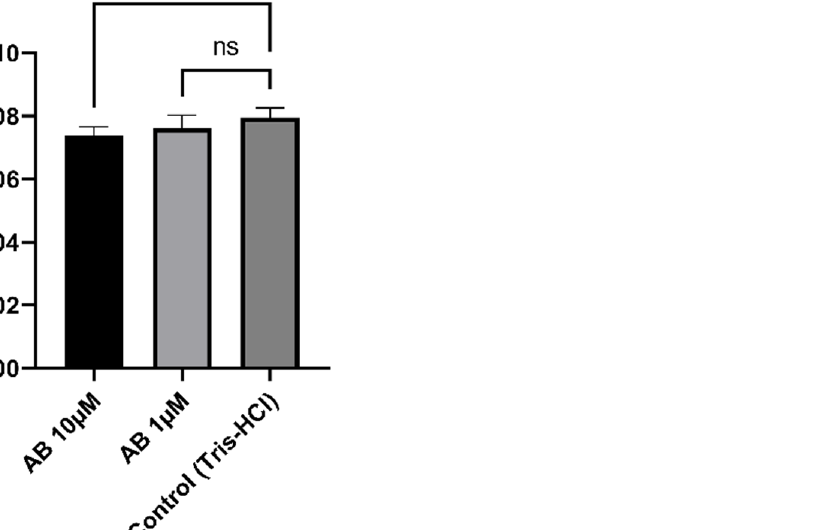
Figure 6. Effect of HstN and HstP on peroxidase activity in SH-SY5Y-APP 695 cells. Peroxidase activity in SH-SY5Y-APP 695 cells: ( A ) incubated for 24 h with HstN, with PC as control, and ( B ) incubated for 24 h with HstP, with ethanol as control. Respective mean values ± SD are shown, N = 10. Significance was determined by unpaired Student’s t-test. **** p < 0.0001. HstN, hesperetin nanocrystal; HstP, hesperetin in pure form; PC, PlantaCare; EtOH, ethanol.